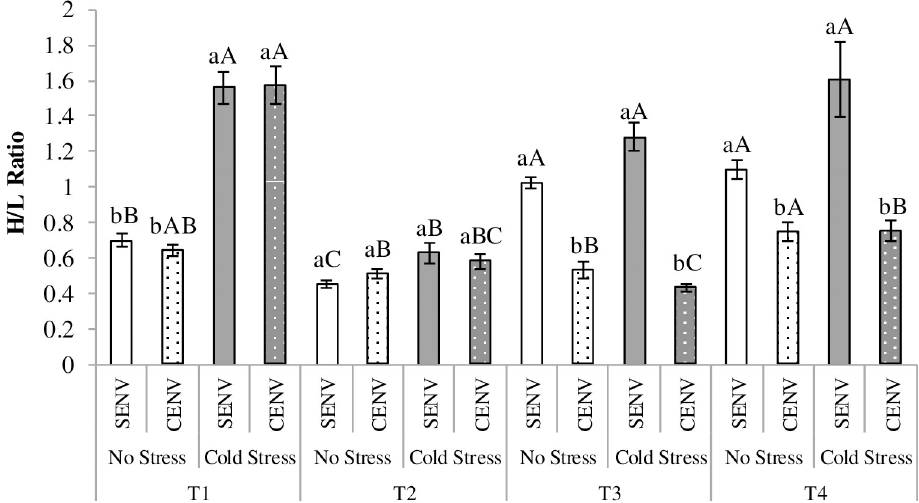
Fig 7. Heterophil/lymphocyte ratio evolution according to the different treatments. Mean ( ± se) Heterophil/ lymphocyte (H/L) ratios in Cold Stress (CSTR) and No Stress (NSTR) birds kept in the Simple Environment (SENV) and a Complex Environment (CENV); NSTR treatment is represented by white bars, while CSTR by grey bars; SENV is represented by bars with a solid colour and CENV by bars with dots; (a-b) letters indicate differences between treatments at each sampling day and (A-C) letters indicate differences between the four different sample points; (T1) 2 days after hatching (directly after the exposure to the CSTR/NSTR treatment); (T2) 18 days after hatching; (T3) 28 days after hatching (just after the 5-days of exposure to the ISCP); (T4) 36 days after hatching (one week after the exposure to the ISCP).